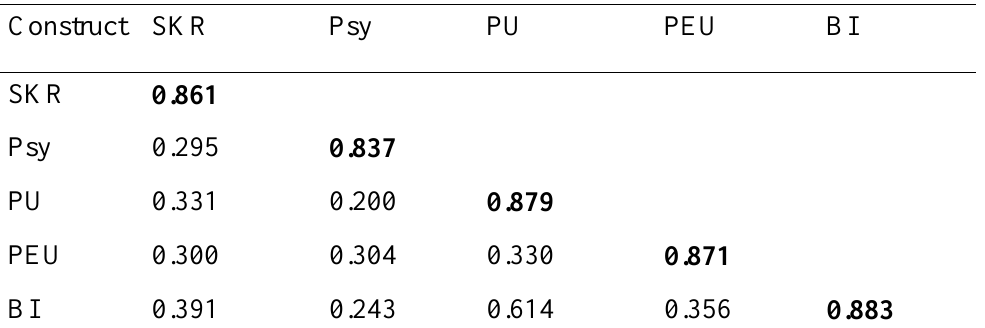
Discriminant Validity for the Measurement Model